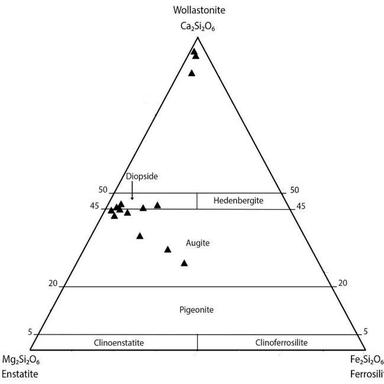
Ternary plot Wo-En-Fs for the pyroxene minerals in the ViS/NM and GNM zone indicating that they form a solid solution between augite and diopside (EDS point measurements of pyroxene minerals see S.I. 3).